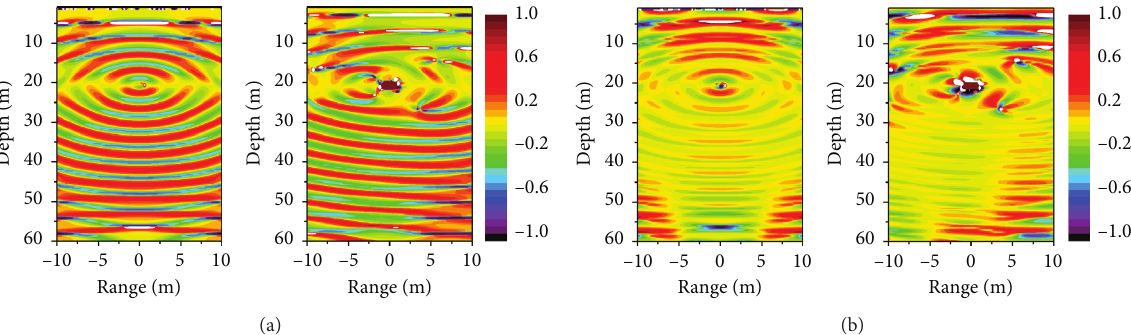
Figure 13: (a) I ∗ z near the source (range from − 10m to 10m. left: point source; right: cylindrical shell) ( f